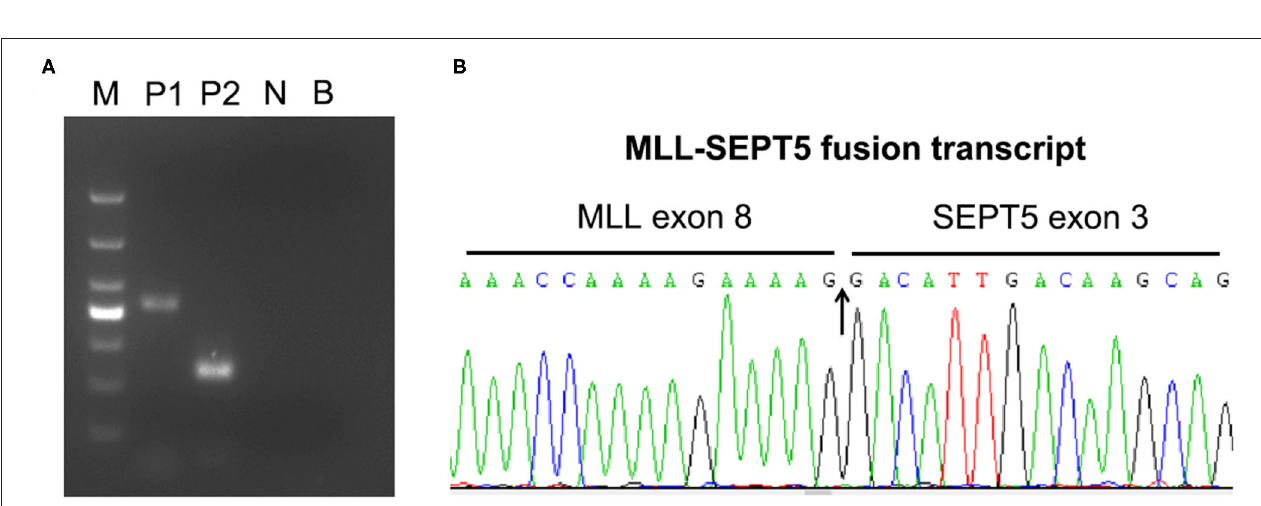
FIGURE 2 | LDI-PCR analyses of MLL translocation partner gene. (A) Genomic DNA of healthy individual and the patient were tested with five different primer combinations (A–C, A–D, A–E, A–F and B–Y). (Left) control DNA (healthy individual peripheral blood). (Middle) DNA marker (TaKaRa, 3584A). (Right) the patient. (B) Sequence analysis of the SEPT5-MLL fusion gene showing juxtaposition of SEPT5 intron 2 and MLL intron 8. “T”was used to connect the two broken chromosomes.